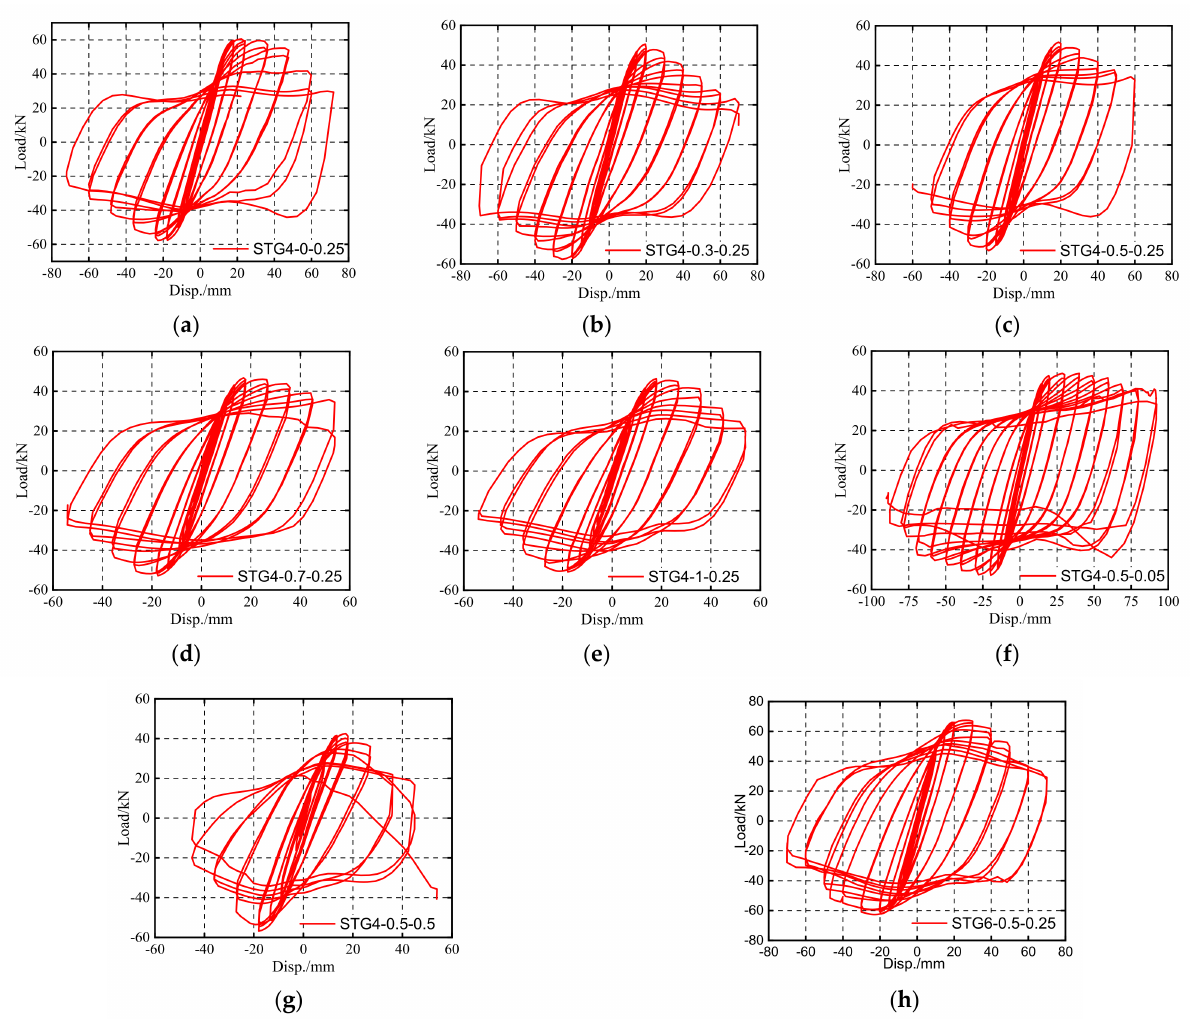
Figure 8. ( a ) Hysteresis curves for GRBACFST columns of STG4-0-0.25; ( b ) hysteresis curves for GRBACFST columns of STG4-0.3-0.25; ( c ) hysteresis curves for GRBACFST columns of STG4-0.5-0.25; ( d ) hysteresis curves for GRBACFST columns of STG4-0.7-0.25; ( e ) hysteresis curves for GRBACFST columns of STG4-1-0.25; ( f ) hysteresis curves for GRBACFST columns of STG4-0.5-0.05; ( g ) hysteresis curves for GRBACFST columns of STG4-0.5-0.25; ( h ) hysteresis curves for GRBACFST columns of STG4-0.5-0.5.